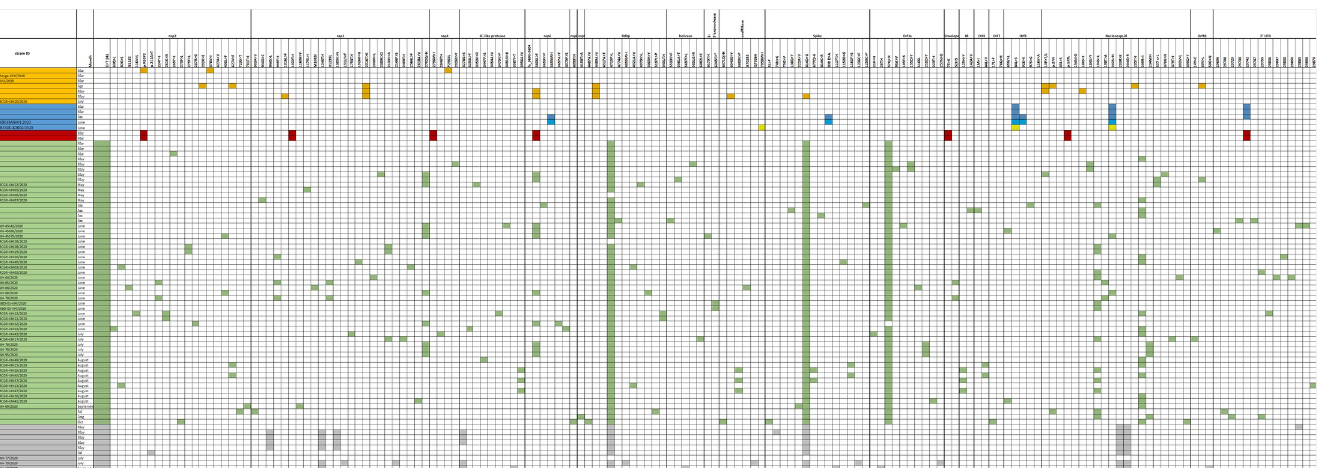
5’ UTR; 241C > T (78.8%), S gene D614G (76%) Orf1ab; Nsp3 924F (74%), Orf1ab; RdRp P4715L (72%), Orf3a Q57H (70%), exonuclease 1ab 6205L (51%), M gene 71Y (51%). N gene R209I (20%), Orf1ab; nsp6 L3606F (15%), N geneS194L (15%), Orf1ab; Nsp3 Q2702H (13%), Fig 4. Of the mutations in Orf1ab, six were associated with evolutionary changes; 8782 (nsp4 2839S), 14408 (RdRp P4715L), 1397 (nsp2 V378I), 3037 (nsp3 924F) and 1059 (nsp3 T265I). G clade strains displayed the greatest number of variations with lineage associated variants including nsp3 924F, RdRp P4715L and S D614G. A GH clade strain from May had L lineage associated mutation (Orf1ab L3606F and P323L) in addition to those typical of its clade. Seventy-nine different non-synonymous SNVs were observed in the Orf1ab gene encoding the non-structural proteins with the greatest number observed in the nsp3 (n = 21), nsp2